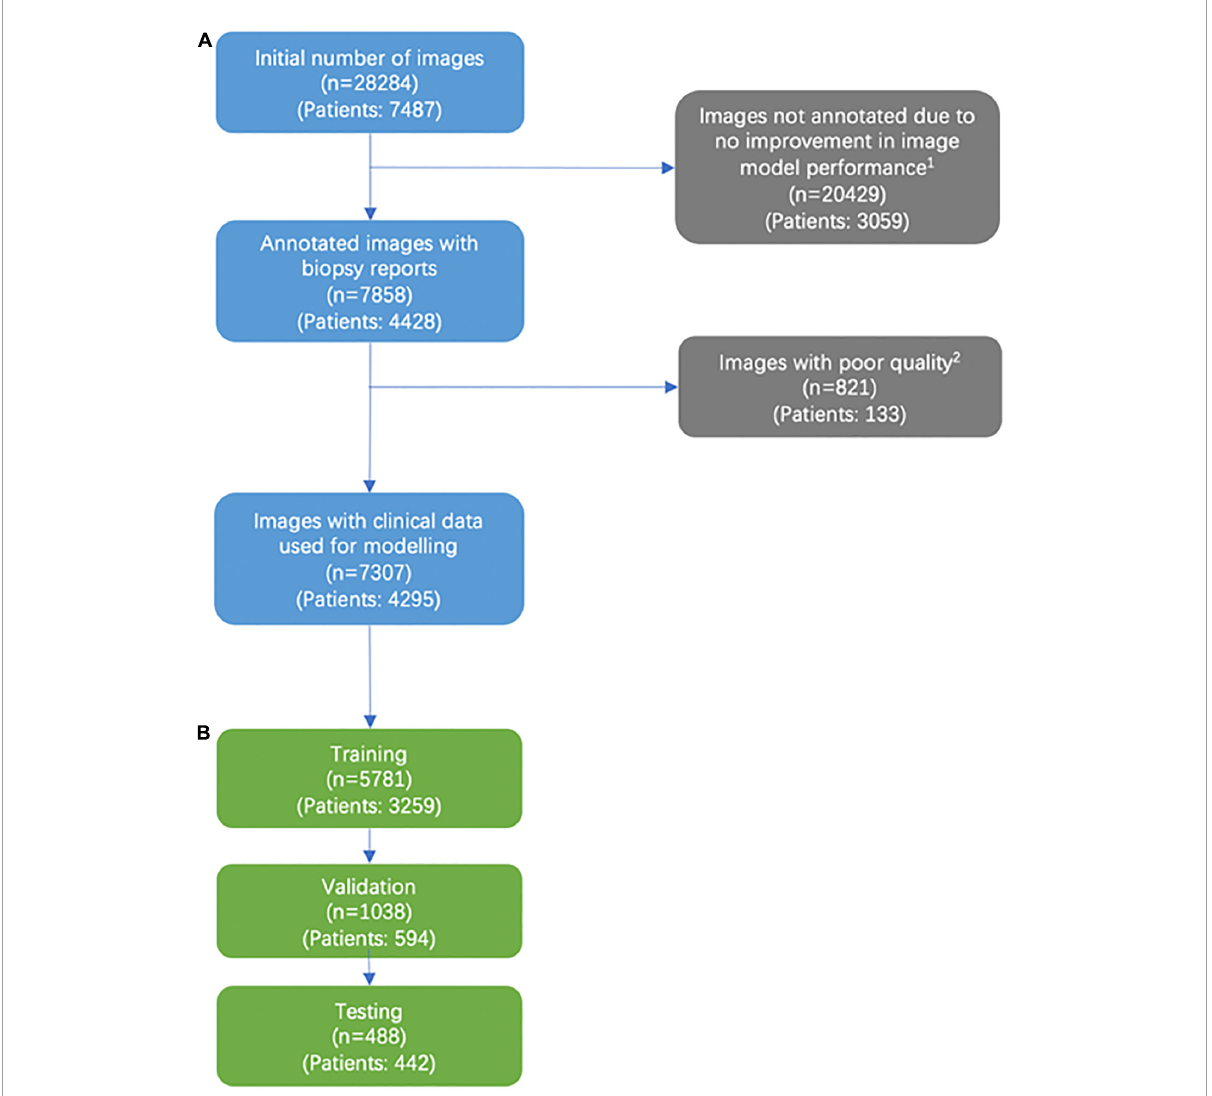
FIGURE1 Consort diagram of image selection. (A) Addition of labeled images past the 5,141 images that were labeled were found to not significantly improve model performance. (B) We excluded images that were deemed not helpful for training our models based on a variety of factors, including images deemed of unusable quality (very low pixels for the area of interest, poor light exposure) and images with predominantly rash